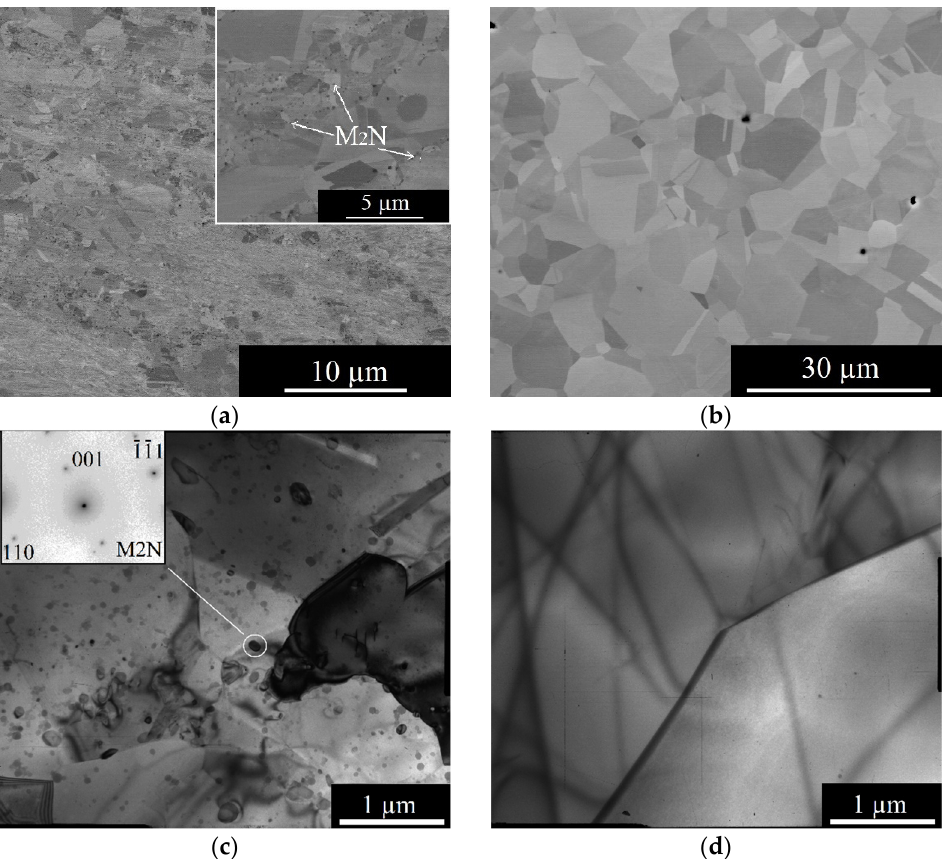
Figure 6. Microstructure of the N2 alloy after cold rolling and annealing at 700 ◦ C ( a , c ) and 900 ◦ C ( b , d ): SEM-BSE images—( a , b ), EBSD phase maps—( c , d ).